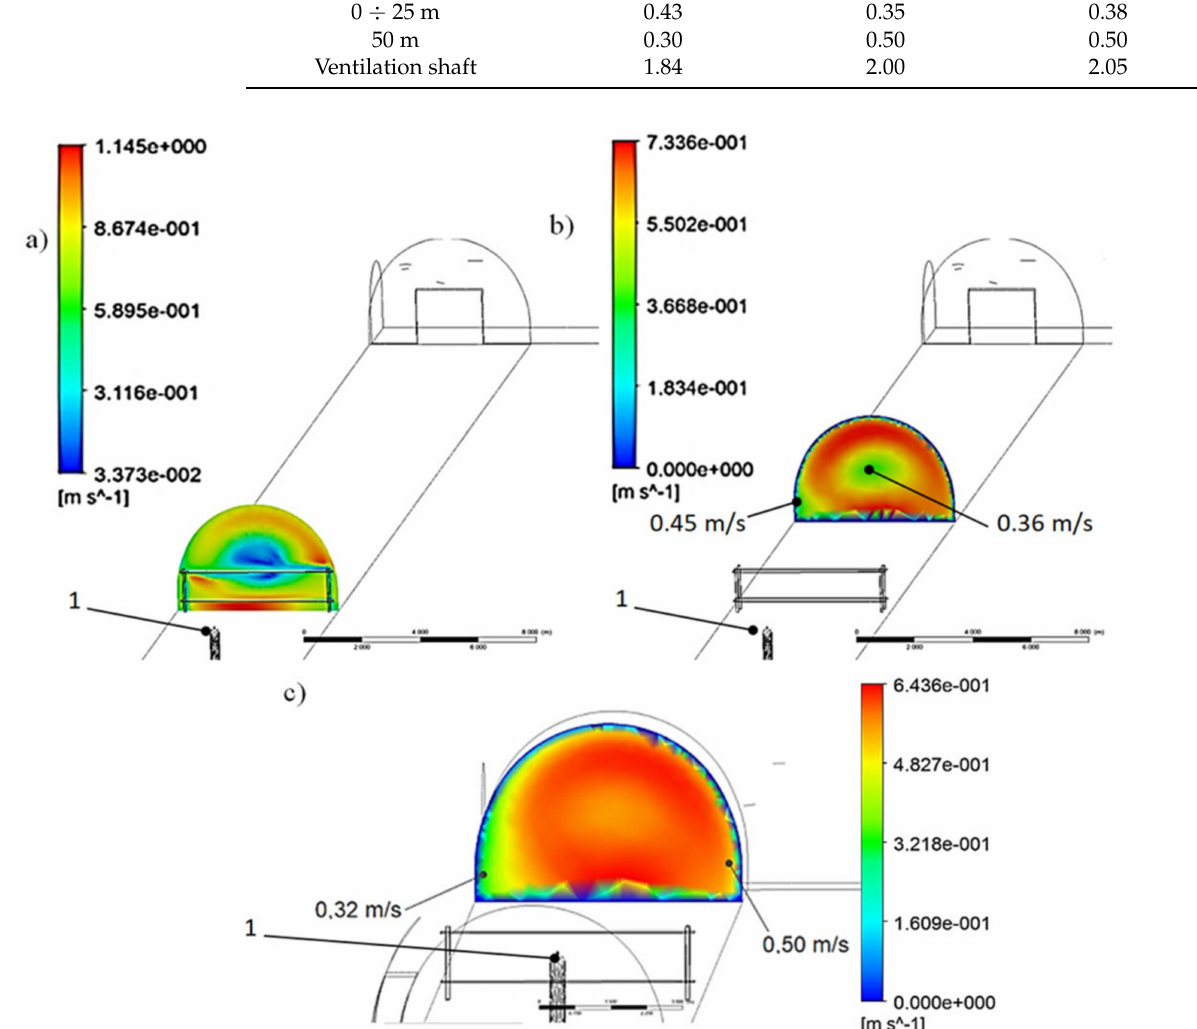
Figure 9. Air velocity in the cross-section of the excavation: ( a ) 10 m from the nozzle, ( b ) 25 m from the nozzle, ( c ) 50 m from the nozzle, 1—water